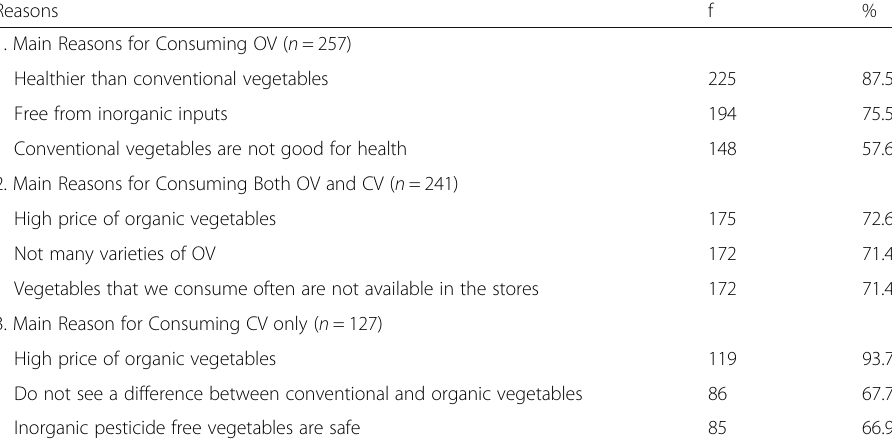
Table 8 Reasons for consuming vegetables (Multiple-Response)